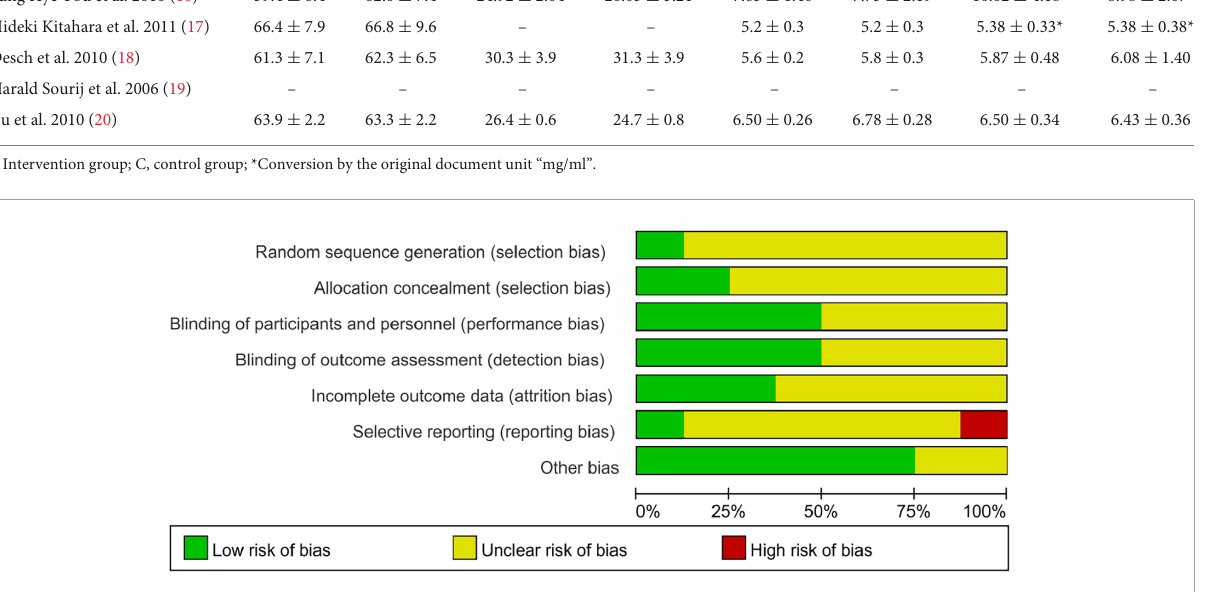
FIGURE2 Schematic representation of the risk of bias.